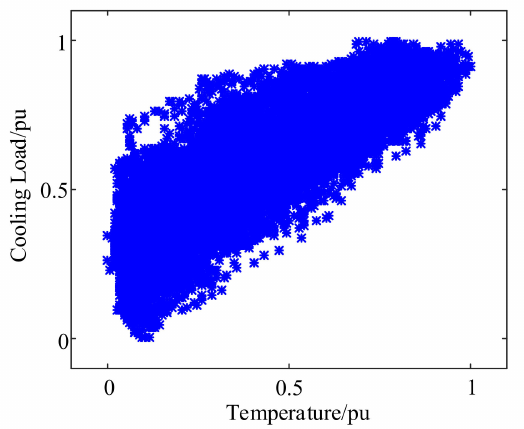
Figure 4. Scatter diagram of cooling load and